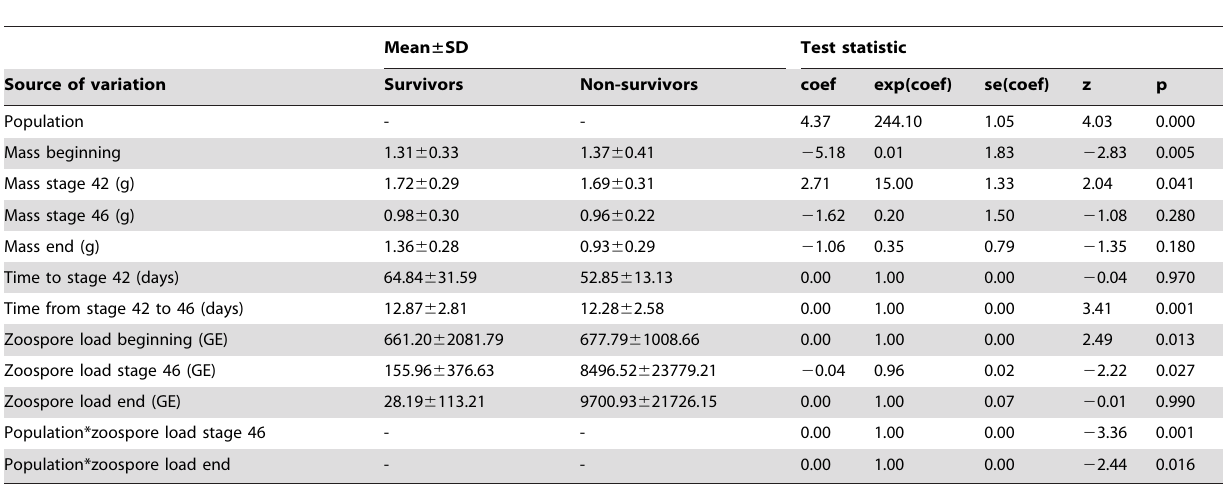
Table 1. Summary of the results of the Cox regression survival analysis of the two treatments with infected